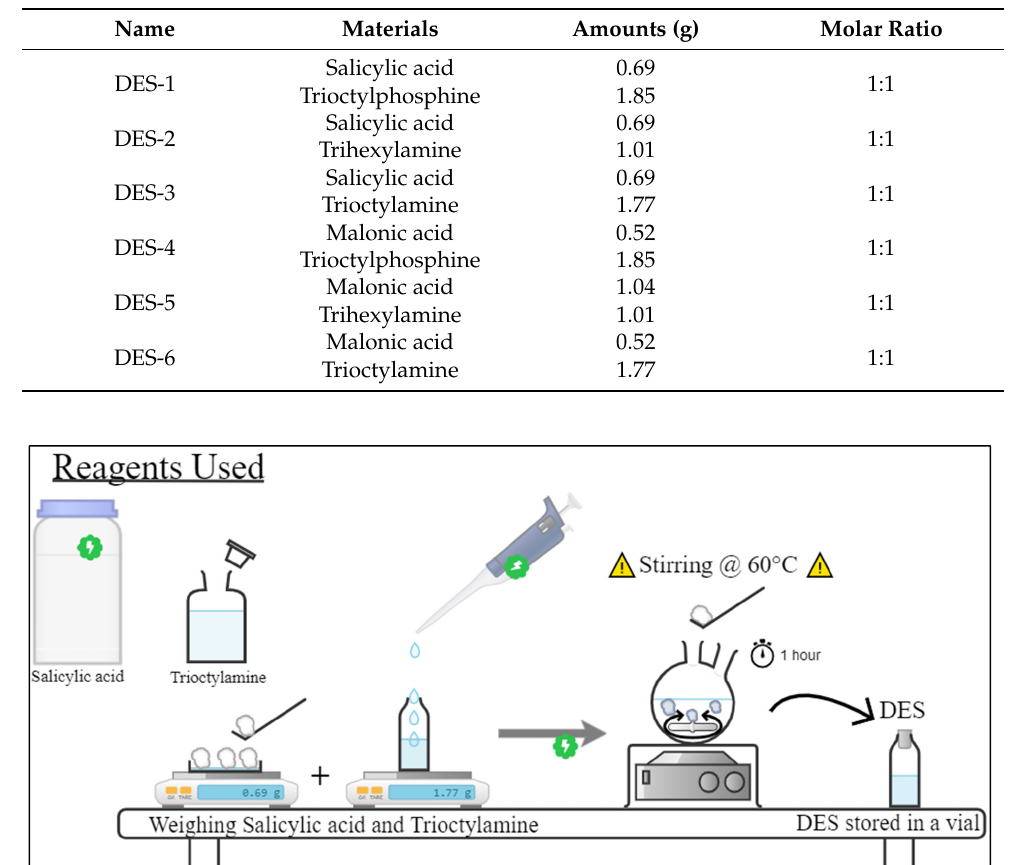
Figure 2. Schematic diagram for the preparation of the DESs.